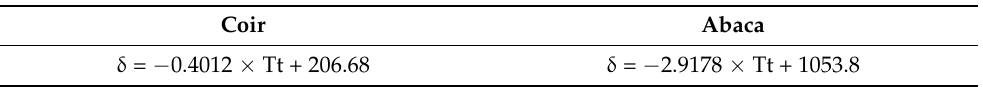
Table 2. Trend equations: Influence of the tensile strength on the fiber transverse dimension of the tested coir and abaca fibers ( δ —tensile strength, Tt—treatment